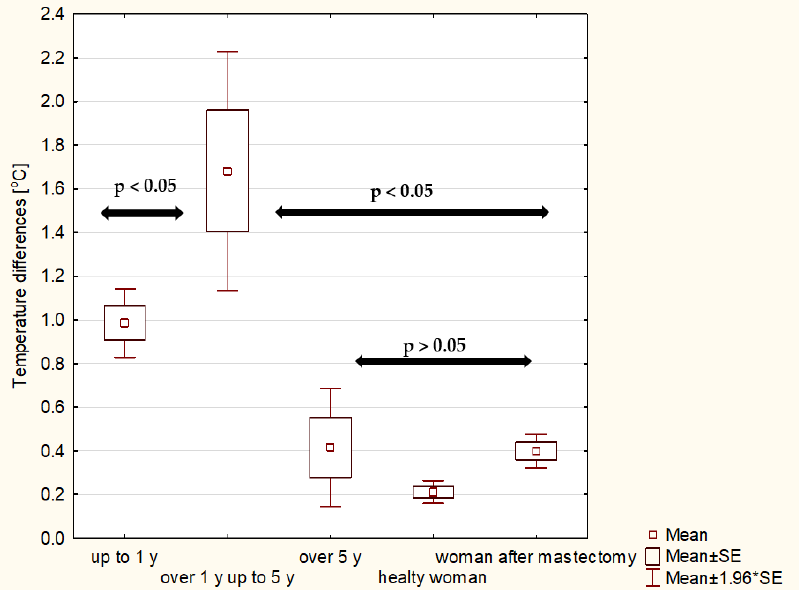
Figure 7. The average temperature difference for irradiated patients after mastectomy obtained be- tween breasts in three time intervals: up to 1 year ago, over 1 year and up to 5 years and over 5 years ago for patients after mastectomy. The results for healthy women and women after mastectomy have been added to the comparison.